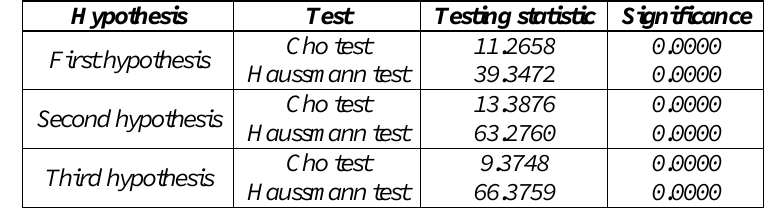
Table 4. The related findings to selection of the given model for testing hypotheses